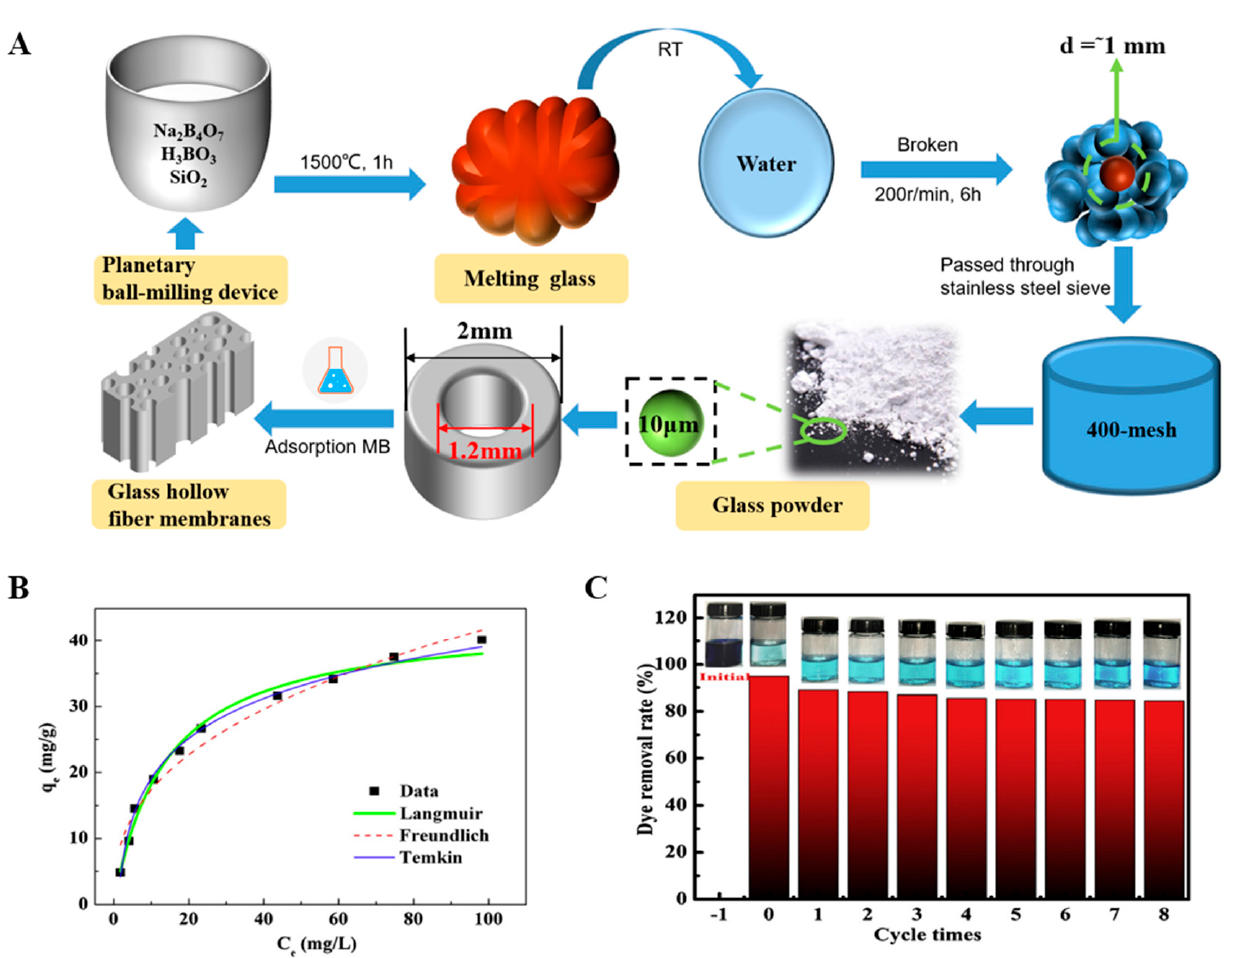
Figure 20. ( A ) Preparation of glass hollow-fiber membranes. ( B ) Adsorption isotherms and their simulations by three isotherm models for as-prepared membrane. ( C ) The removal ratio of the as- prepared membrane and the glass membrane after eight adsorption-calcination cycles. Reproduced with permission from reference [148]. Copyright 2019 Journal of the European Ceramic Society .